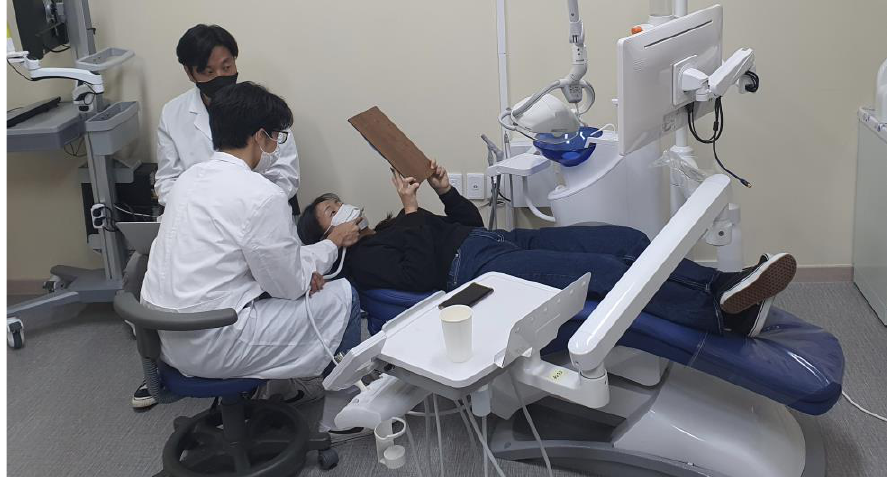
Figure 4. Clinical trial method of sound masking technology.